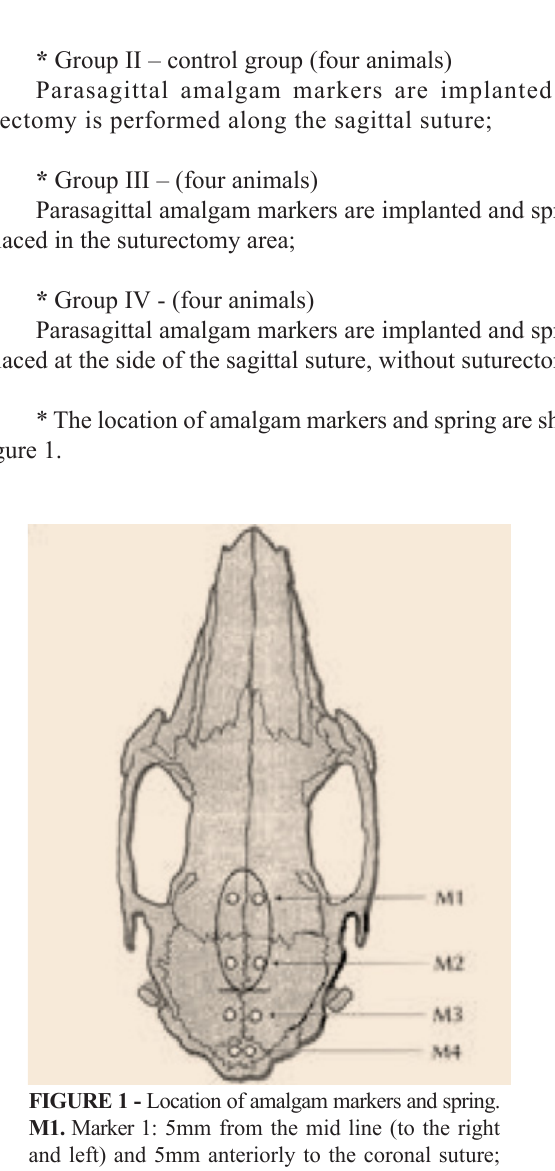
and left) and 5mm posteriorly to the lambdoid